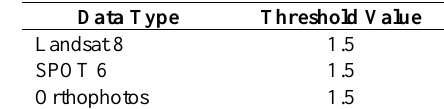
Table 2. Threshold setting in MLC